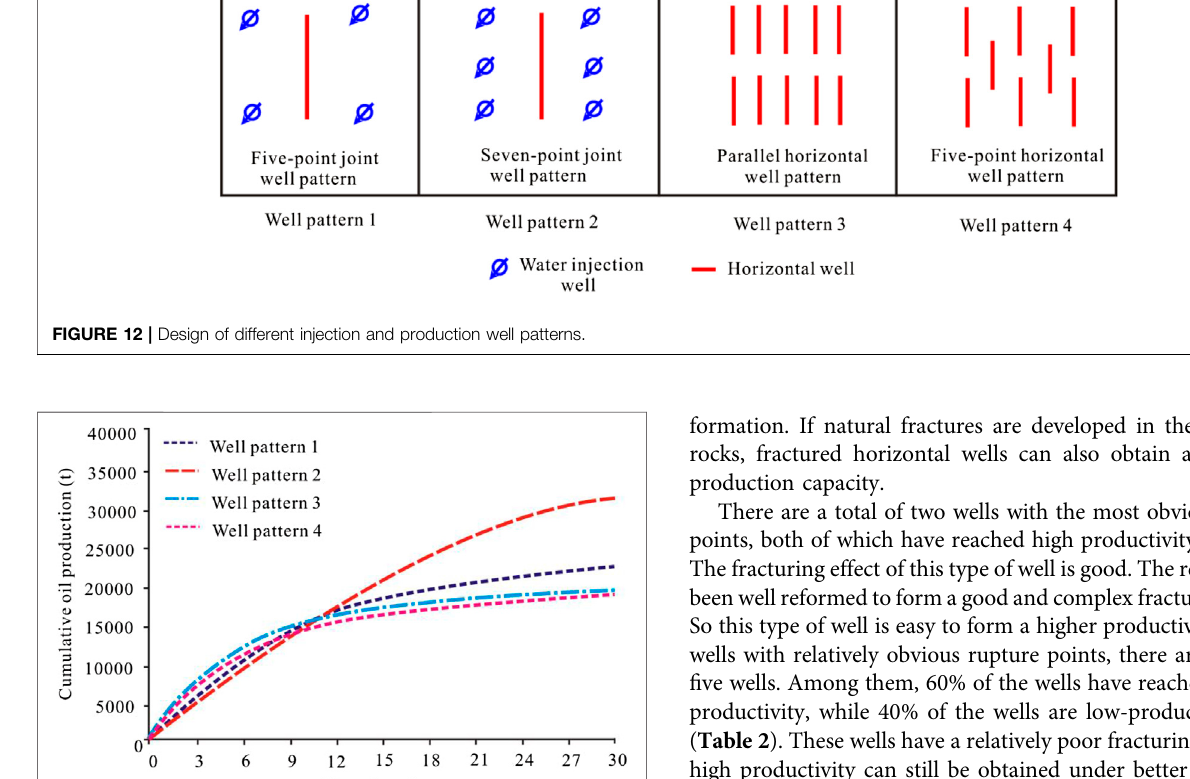
Frontiers in Earth Science |